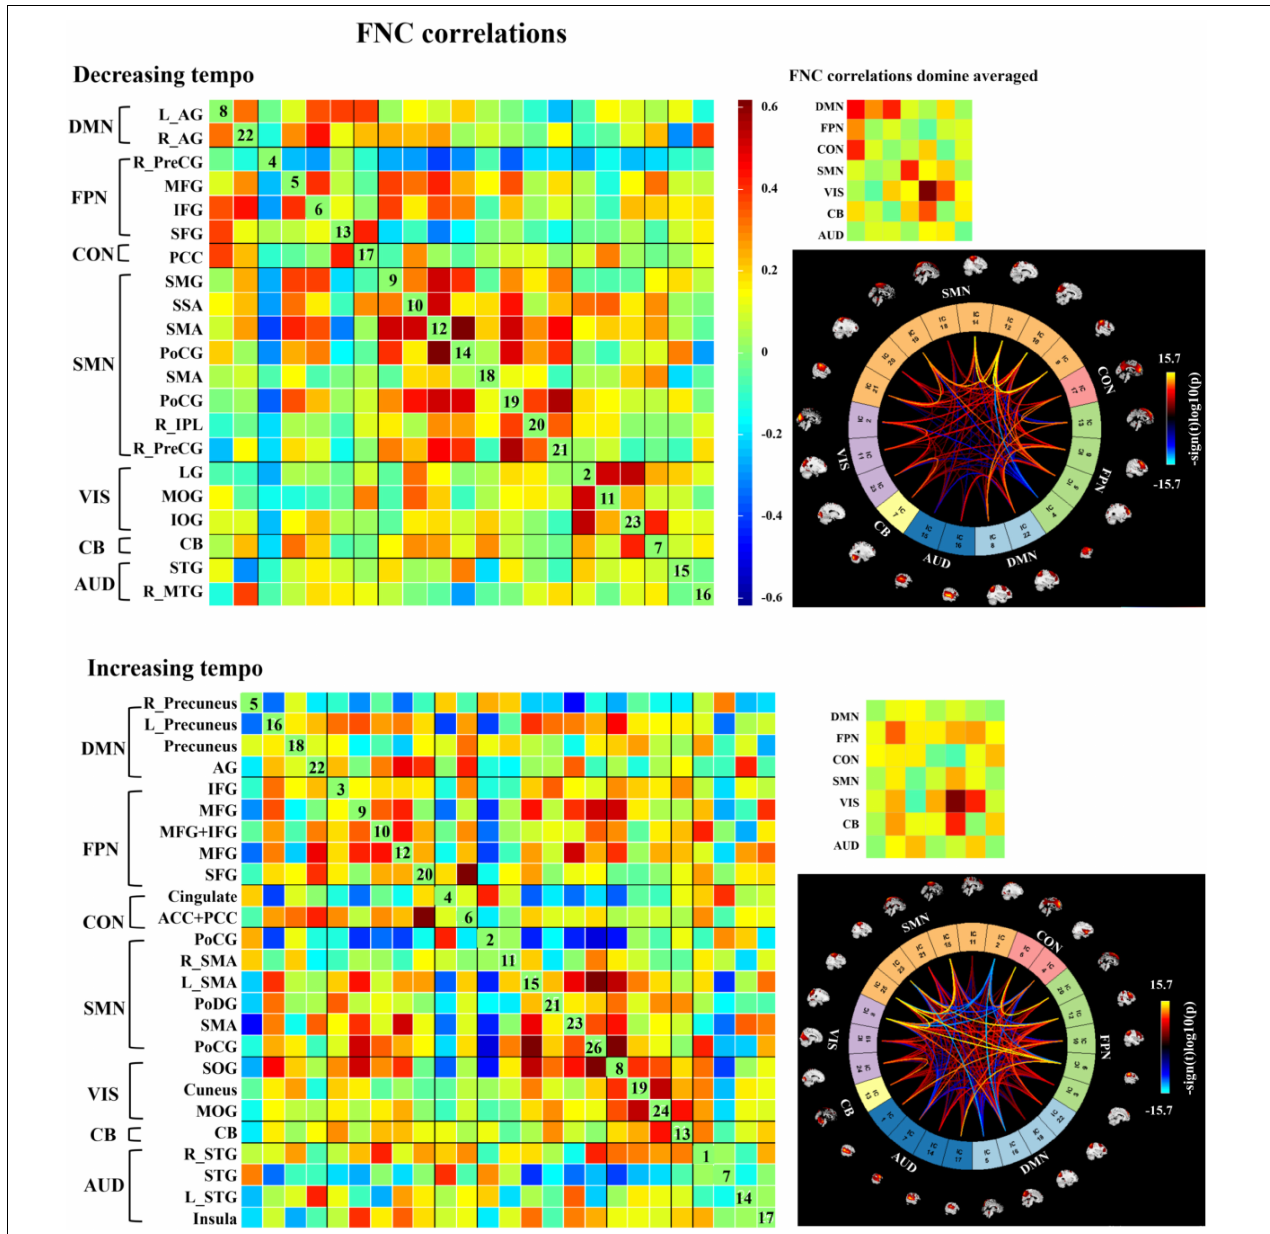
FIGURE 6 | Group ICA in the two kinds of music. In each level, the left matrix displays the FNC correlations averaged over subjects. In the upper right corner, the small matrix presents the correlations averaged in each network. In the bottom right, the connectogram displays the significant effects when p < 0.001, and the distribution of the color bar means the T score. AG, angular gyrus; IFG, inferior frontal gyrus; PFC, prefrontal cortex; dlPFC, dorsal lateral prefrontal cortex; MFG, middle frontal gyrus; IPL, inferior parietal lobe; SPL, superior parietal lobe; PoCG, postcentral gyrus; PreCG, precentral gyrus; SMA, sensorimotor area; IOG, inferior occipital gyrus; MOG, middle occipital gyrus; LG, lingual gyrus; PCC, posterior cingulate cortex; CB, cerebellum; SOG, superior occipital gyrus; STG, superior temporal gyrus; MTG, middle temporal gyrus; SAA, somatosensory association area; SAA, sensory association area; SFG, superior frontal gyrus; TTG, transverse temporal gyrus; TL, temporal